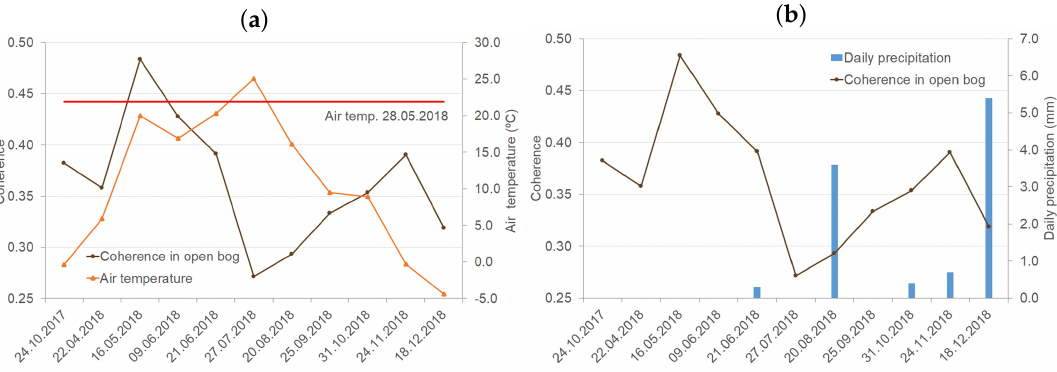
Figure 3. Air temperature ( a ) and sum of daily precipitation ( b ) are not significantly correlated with the magnitude of InSAR coherence in the open bog. The single master image of 28 May 2018 (no precipitation) has been used in coherence estimation.